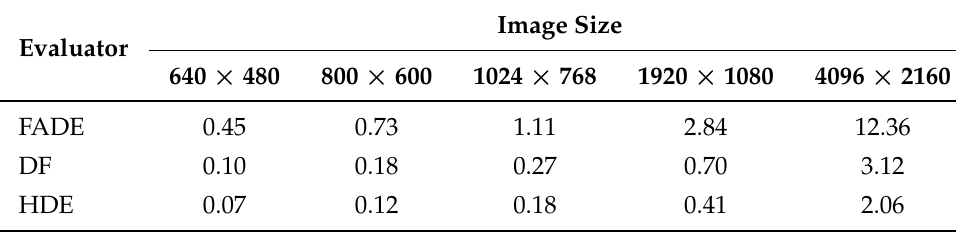
Figure 13. The block diagrams of two benchmark evaluators. Table 8. Run-time in seconds of different haze density evaluators for various image